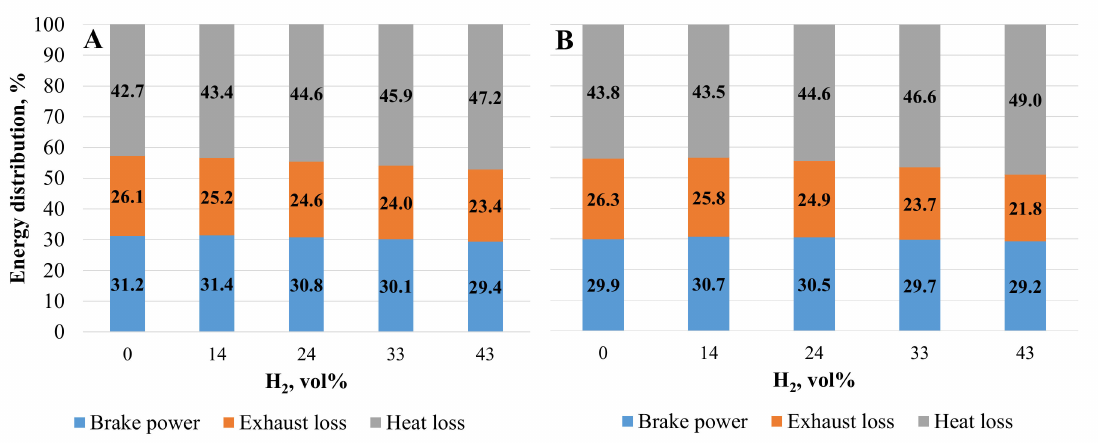
Figure 9. Energy distribution. ( A )—with optimal ST for the mixture; ( B )—with optimal CNG